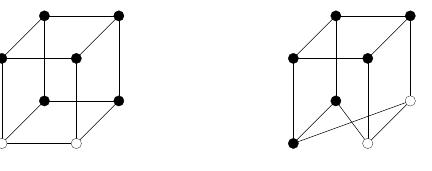
Figure 1. Graphs of order 8 with a strong security number equal to 6, black vertices form a minimum strong secure set.